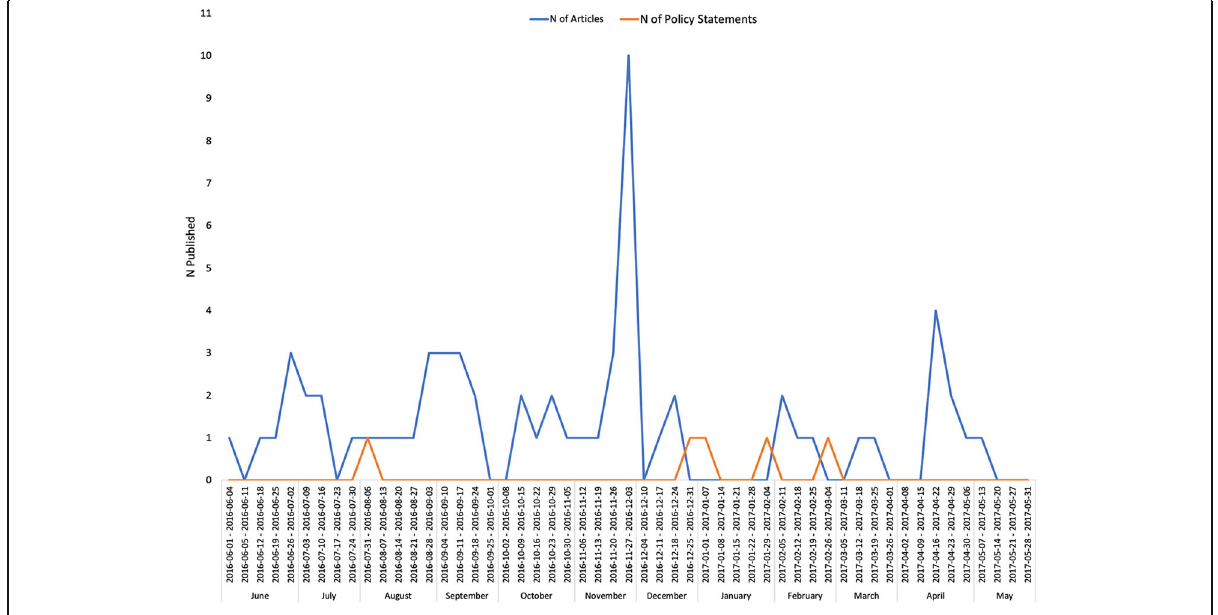
Fig. 2 Frequency of news articles and policy statements from 1 June 2016 to 31 May